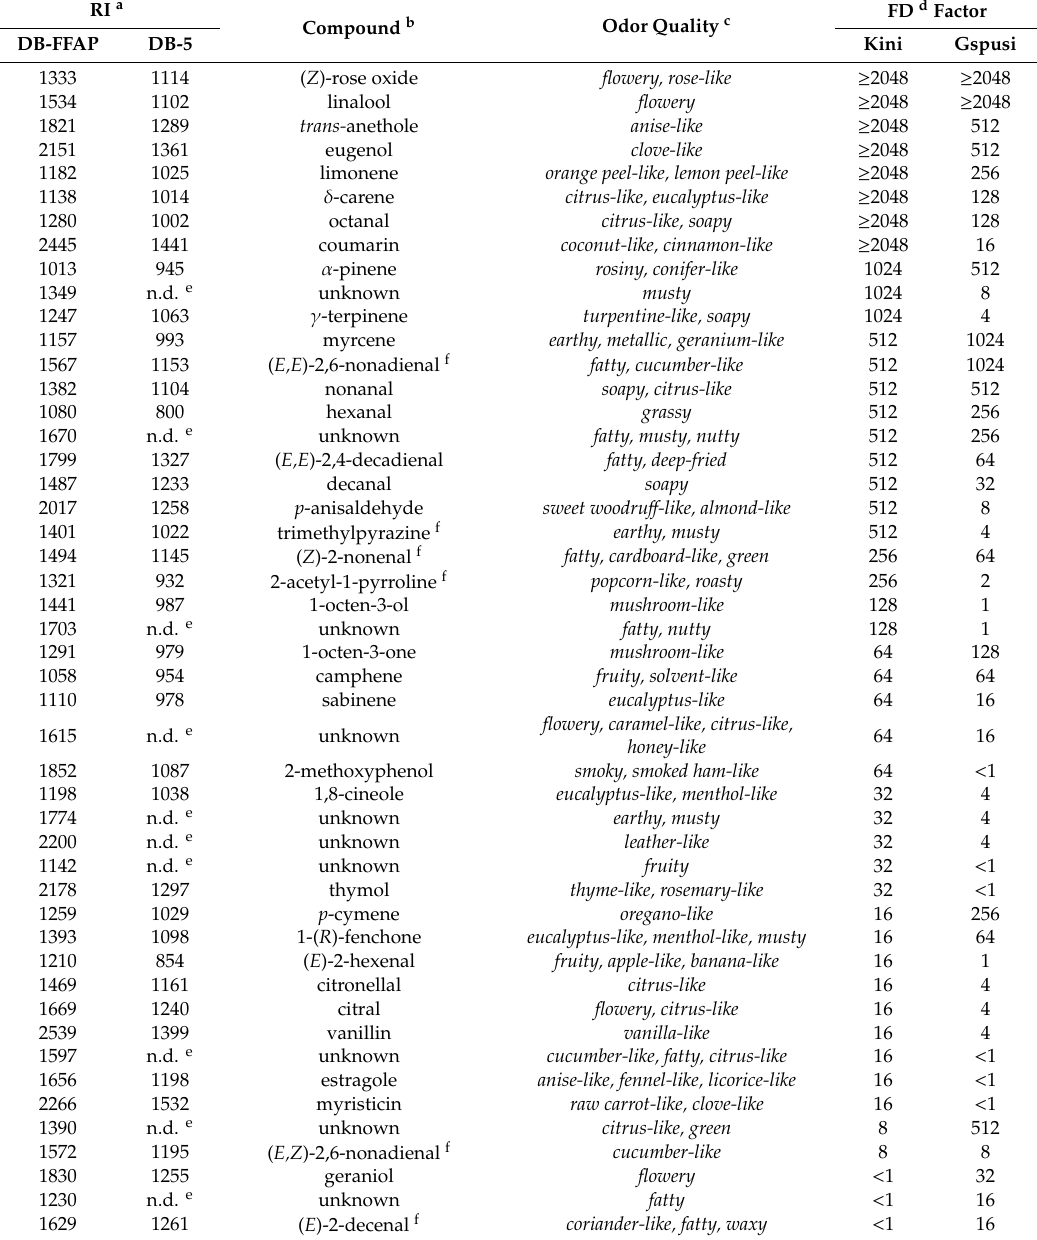
Table 1. Aroma-active compounds identified in distillates obtained from two di ff erent Bavarian gins, The King Gin Kini and Gspusi, and present with flavor dilution (FD) factors ≥ 4 in at least one of the gins. Compounds are listed in order of decreasing FD factor in relation to their presence primarily in Kini, then